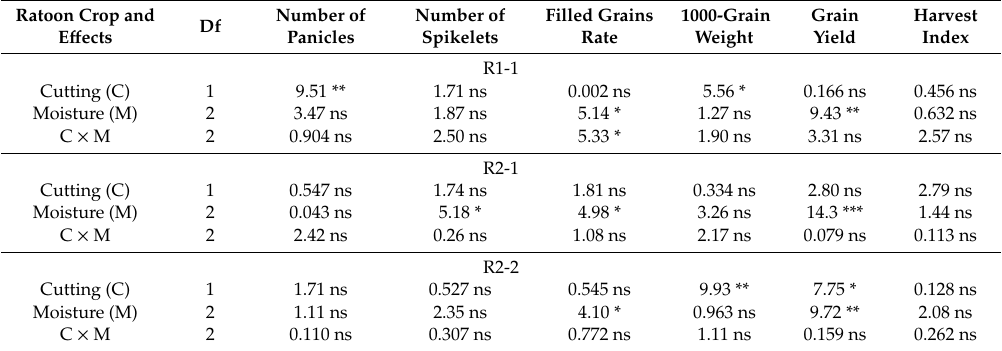
Figure 3. Comparison of differences in cutting and soil moisture regimes on yield components ( a – d ), grain yield ( e ), and harvest index ( f ) of each ratoon. Horizontal dashed lines indicate the mean value of the main crop for each ratoon ( n = 24). R1-1, R2-1, and R2-1 represent the first ratoon of the first main crop, first ratoon of the second main crop, and second ratoon of the second main crop, respectively. M1, M2, and M3 represent saturated, humid, and dry soil moisture regimes, respectively. M1.5 was between the M1 and M2 levels. SC and DC represent single- and double-cutting regimes, respectively. Values for the ratoons represent the mean ± standard error of each treatment ( n = 4). Table 2. F values in analysis of variance (ANOVA) for comparison of yield components, grain yield, and harvest index of each ratoon crop as a ff ected by the cutting and soil moisture